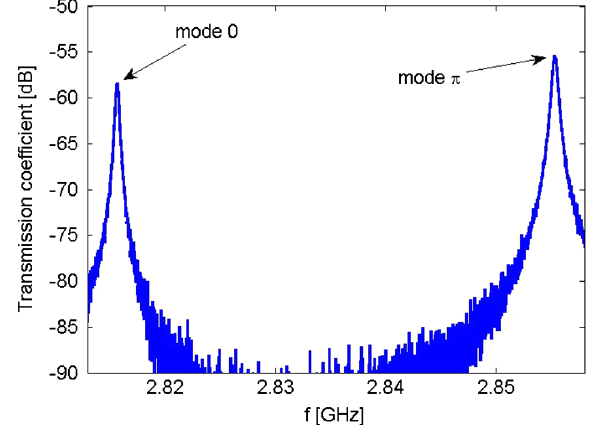
FIG. 11. Radio frequency gun resonant modes (measured in air at 60% relative humidity and 20 °C).